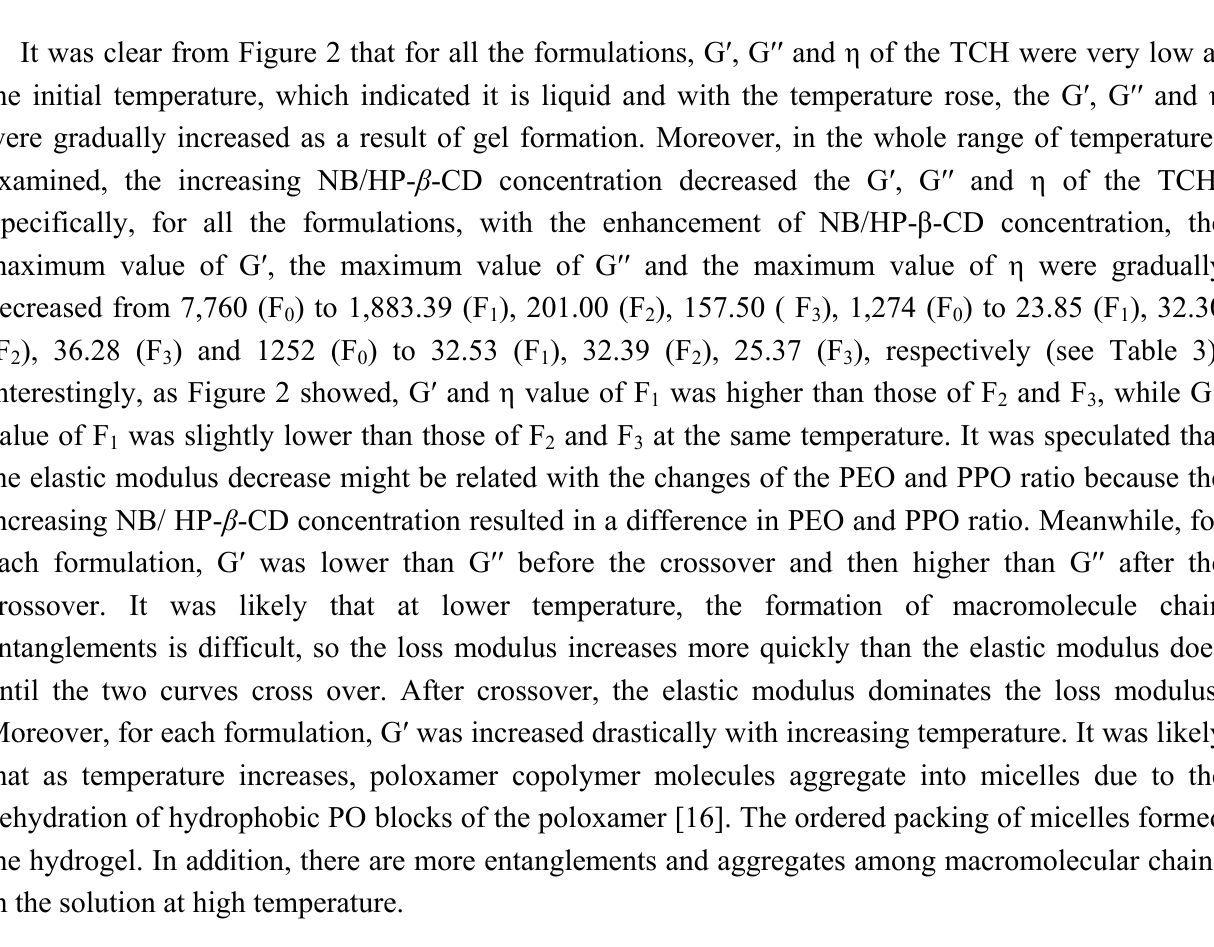
Table 3. The effect of NB/HP- β -CD concentration on rheological properties of thermosensitive composite